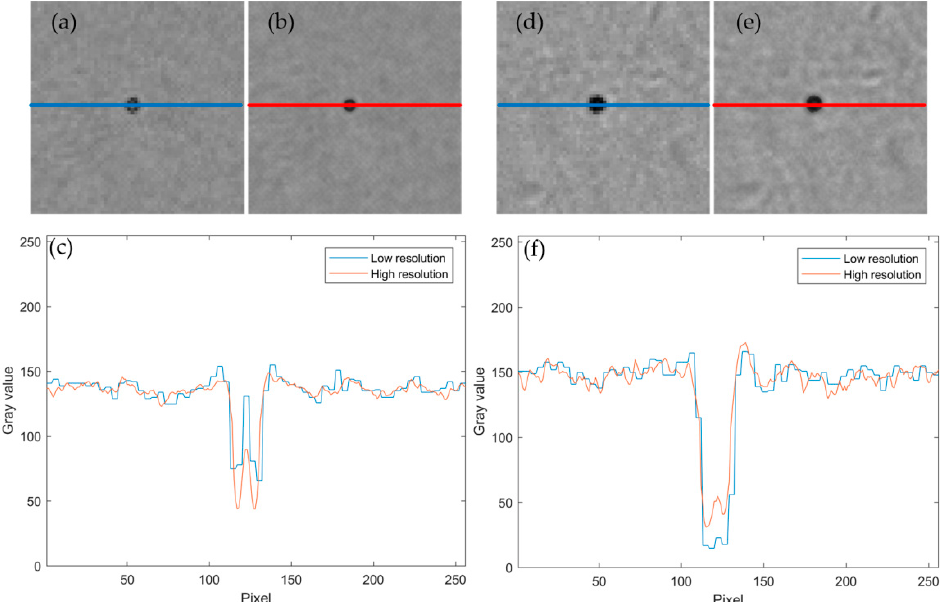
Figure 4. The super-resolution of sample images comparison. ( a ) A low-resolution image of bead. ( b ) A high-resolution image of polystyrene microbead. ( c ) The grayscale change curve of the lines in ( a , b ). ( d ) A low-resolution image of RBC. ( e ) A high-resolution images of RBC. ( f ) The grayscale change curve of the lines in ( d , e ).